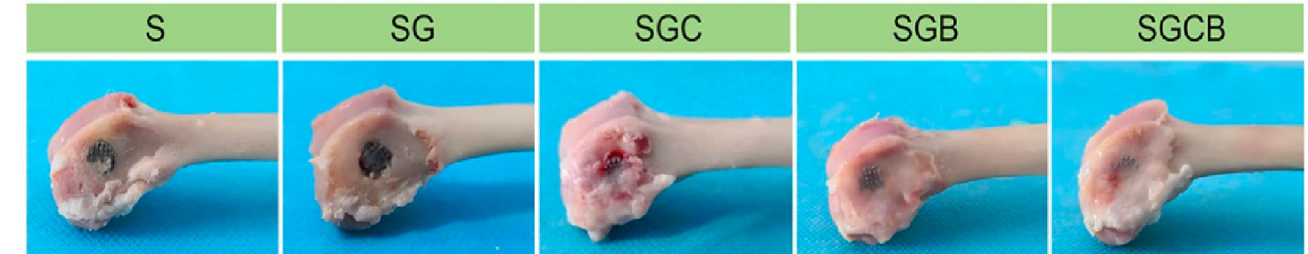
Figure 5. Bone regeneration at the implant interface. (S) scaffold, (SG) scaffold with hydrogels, (SGC) scaffold with bone marrow stem cells (BMSCs) impregnated into hydrogels, (SGB) scaffolds with bone morphogenetic protein ‐ 2 (BMP ‐ 2) impregnated hydrogels, and (SGCB) scaffolds with BMSCs and BMP ‐ 2 impregnated into hydrogels. Figure adapted from reference [40].